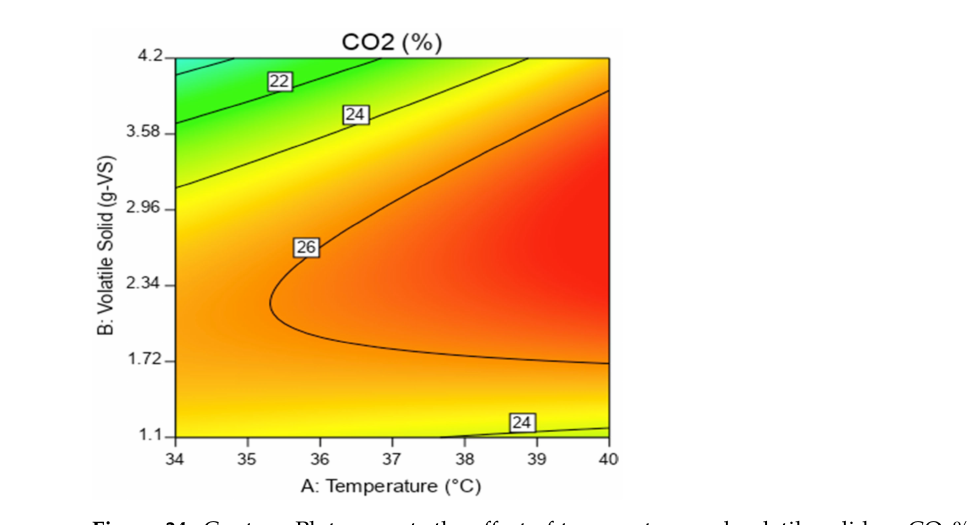
Figure 34. Contour Plot presents the effect of temperature and volatile solid on CO 2 % at sludge quantity of 37.5%.